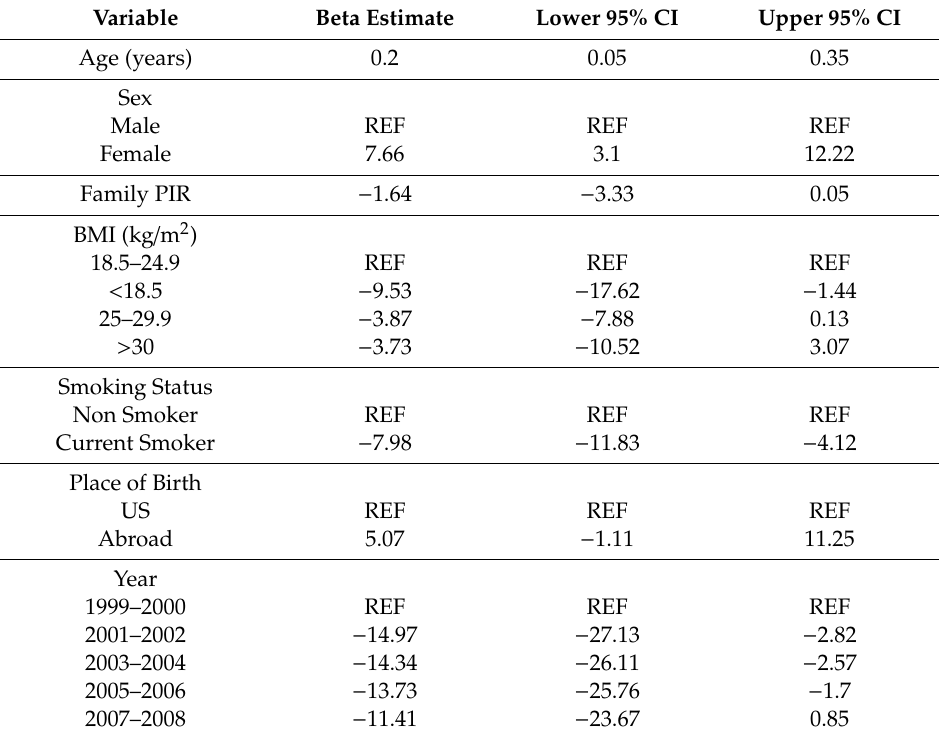
Table 2. Adjusted model estimate in adults sampled in the NHANES study between 1999 and 2008. Variable Beta